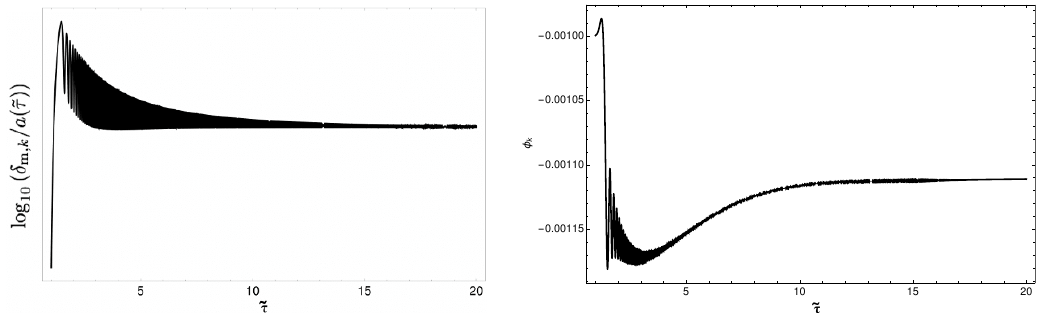
JHEP08(2018)070